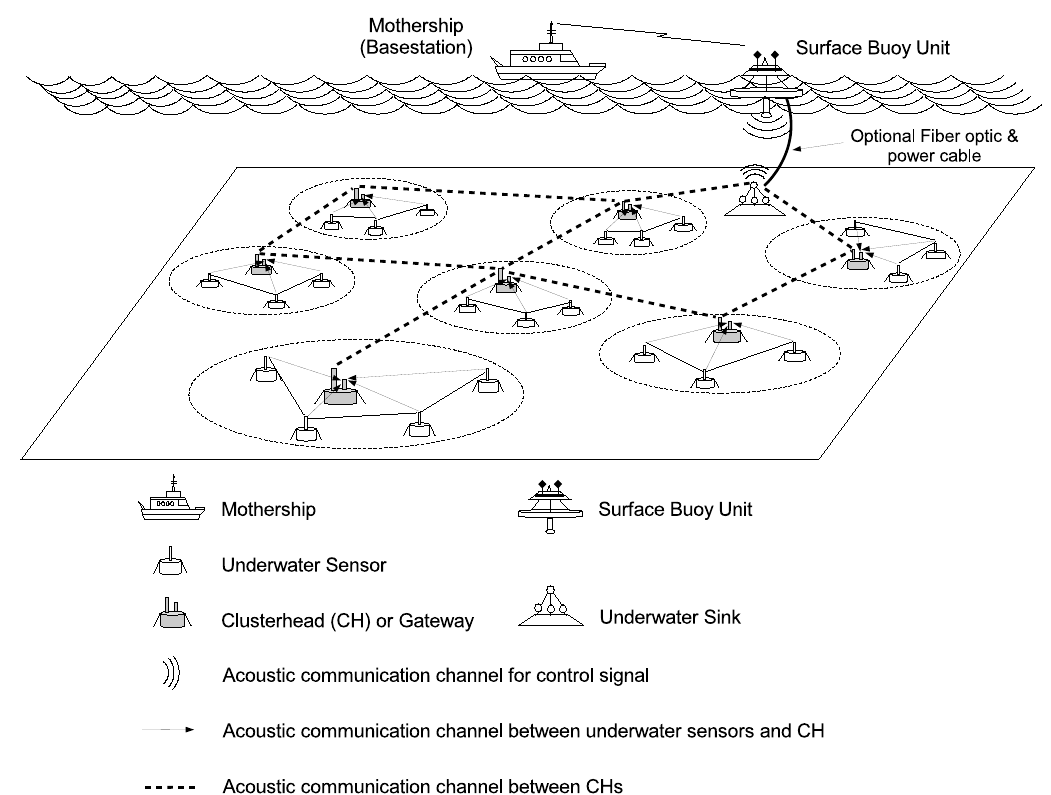
Figure 1. Cluster-based underwater acoustic sensor